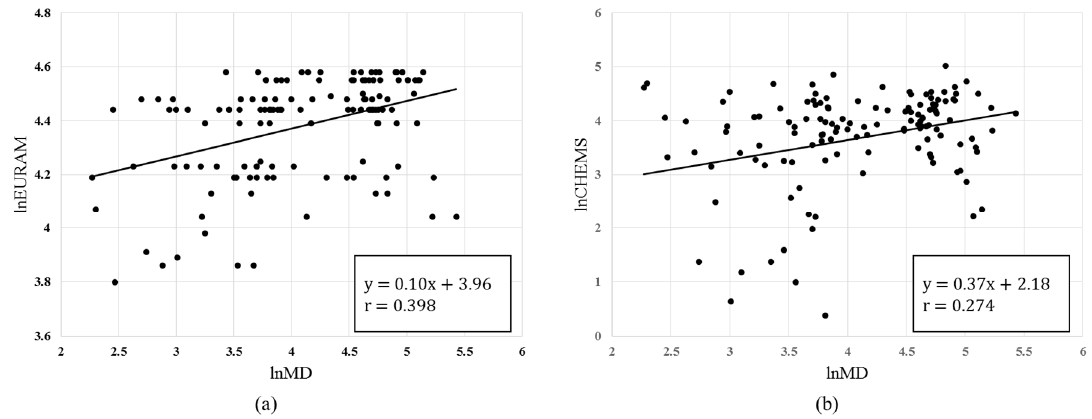
Figure 1. The results of the correlation analysis between the hazard scores calculated using the chemical ranking and scoring methods: ( a ) comparison between Mahalanobis distance (MD) and European Union Risk Ranking Method (EURAM) and ( b ) comparison between MD and Chemical Hazard Evaluation for management Strategies (CHEMS).